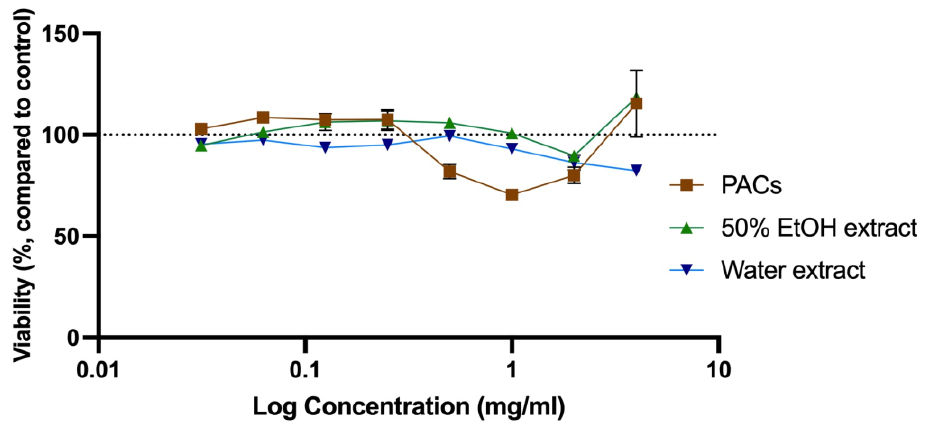
Figure 7. Cytotoxicity of SBT extracts evaluated as viability changes in neutral red uptake test in Balb/c 3T3 cell culture (n = 3). The dotted line corresponds to the control level.